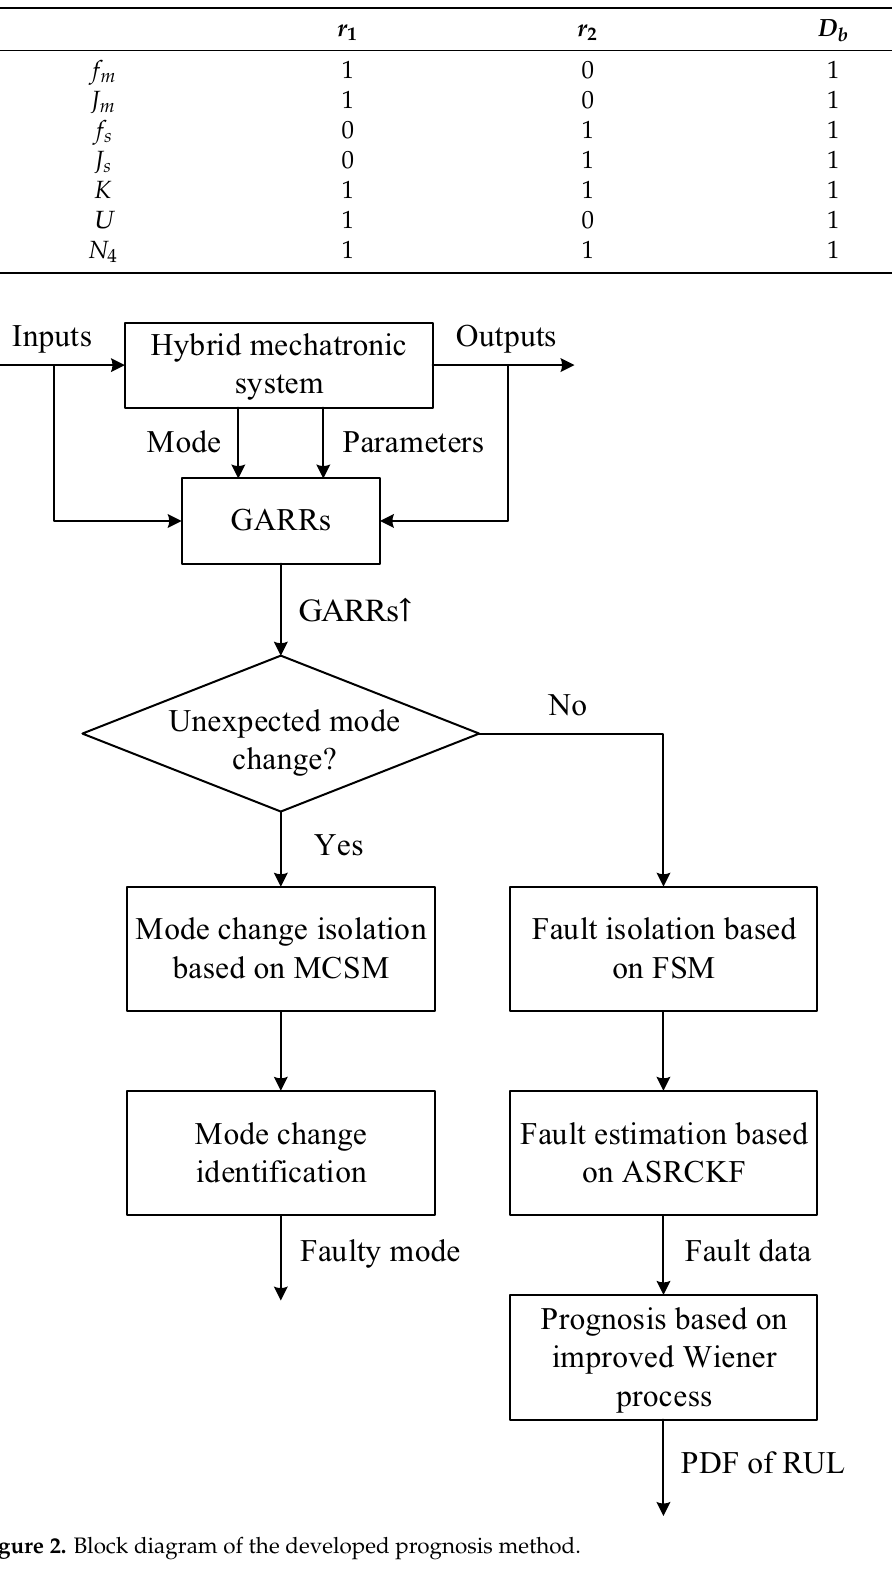
Figure 2. Block diagram of the developed prognosis method.